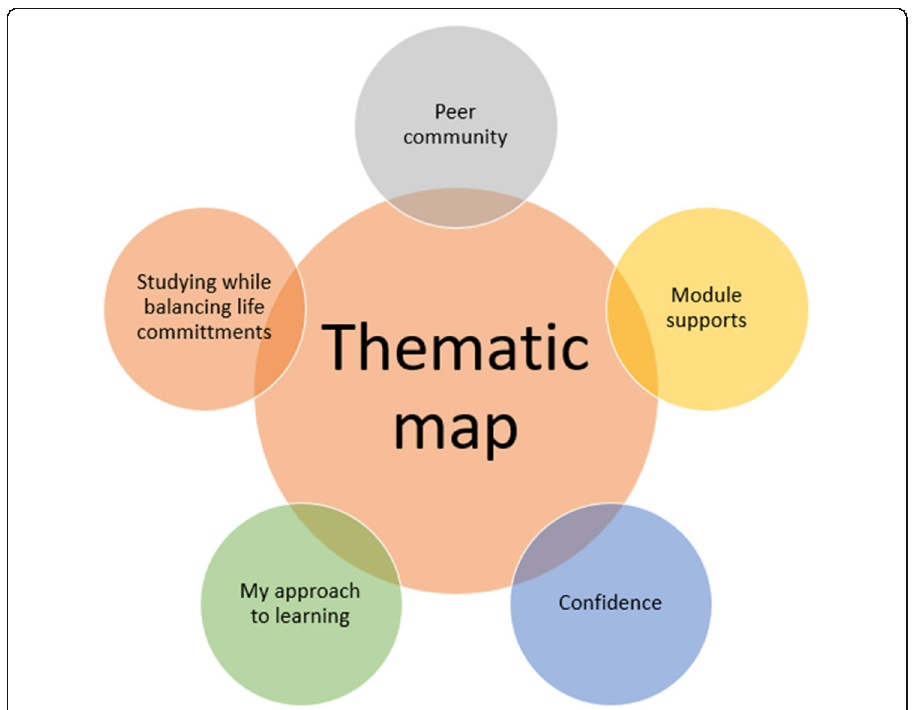
Fig. 2 Final Thematic Map: illustrating five themes constructed in the analytic